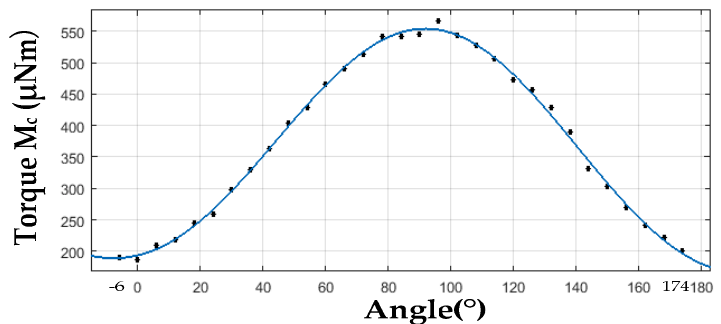
◦ c for different δ ( φ = 1